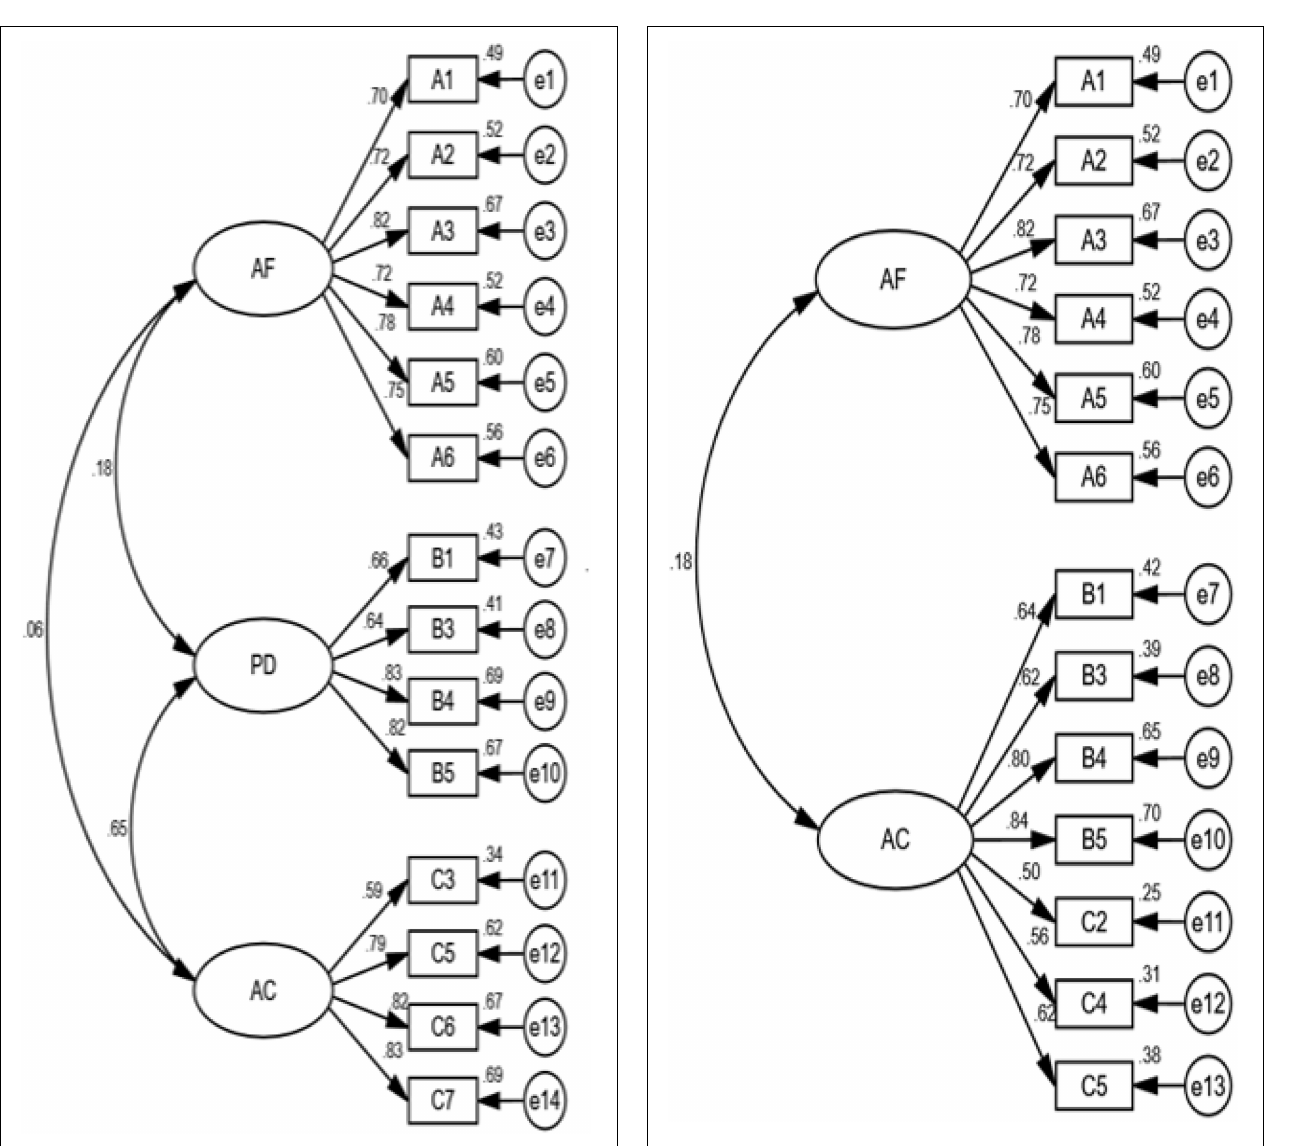
FIGURE 1 | The 3-dimensional confirmatory factor model (left).